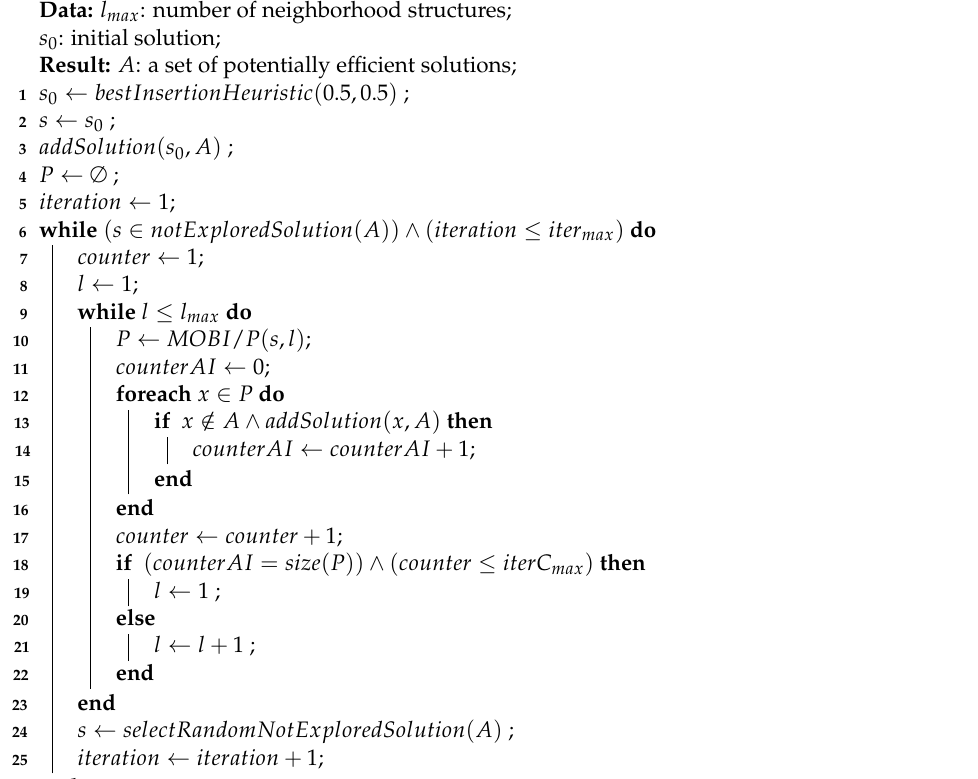
Algorithm 4: Multi-objective VND based on Pareto Dominance Improved